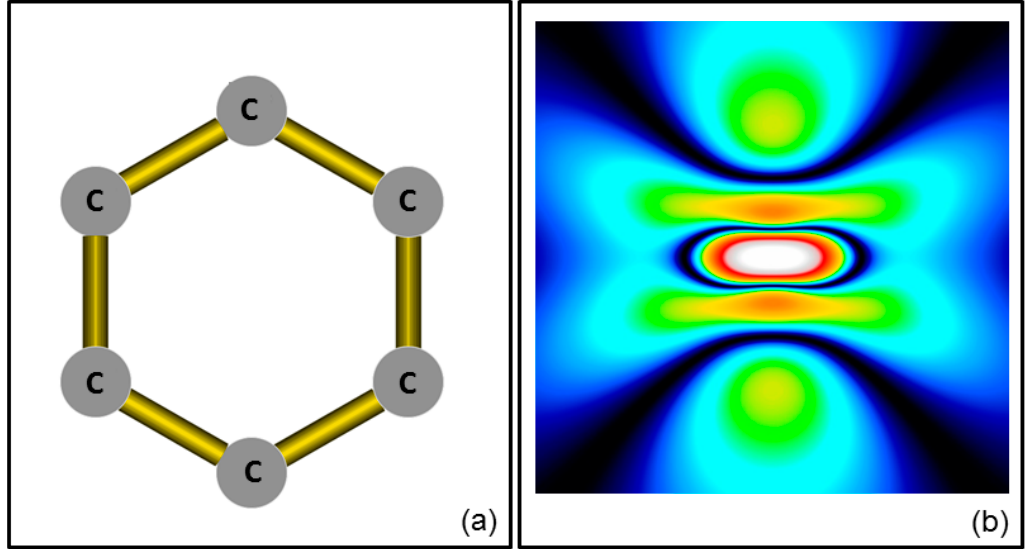
Figure 2. ( a ) Hexagonal ring of carbon atoms; and ( b ) its molecular form factor ( λ = 1.540562 Å, detector pixel size = 100 µm, linear detector size = 20 cm; sample-to-detector distance = 5 cm).